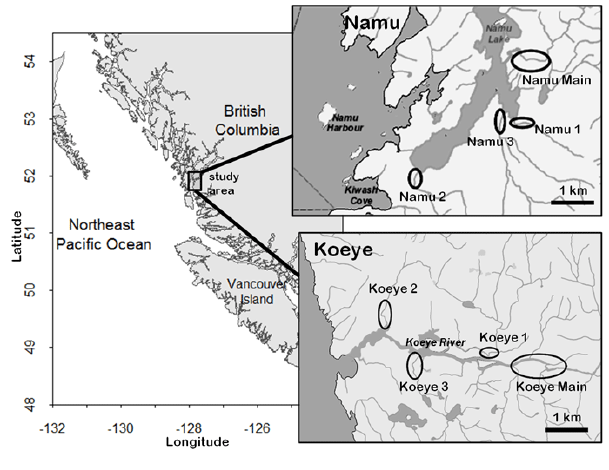
Fig. 1 . Location of stream assessment sites within the Koeye and Namu watersheds of the Great Bear Rainforest, British